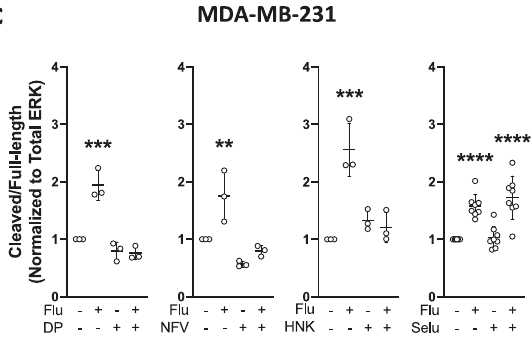
Fig. 3 | Nel fi navir and Honokiol block fl uvastatin-induced SREBP2 activation. a MDA-MB-231 (left) and HCC1937 (right) cells were exposed to solvent controls, fl uvastatin (Flu) +/ − dipyridamole (DP), nel fi navir (NFV), honokiol (HNK) or selu- metinib (Selu) for 16h, and RNA was isolated to assay INSIG1 expression by qRT- PCR. mRNA expression data are normalized to RPL13A expression. Error bars represent the mean±SD, n =3 – 4 biologically independent samples, * p <0.05, ** p <0.01, *** p <0.001, **** p <0.0001 (one-way ANOVA with Bonferroni ’ s multiple comparisons test, where each group was compared to the solvent control group within each experiment). b MDA-MB-231 and HCC1937 cells were treated with fl uvastatin+/ − dipyridamole, nel fi navir, honokiol or selumetinib for 12h, and